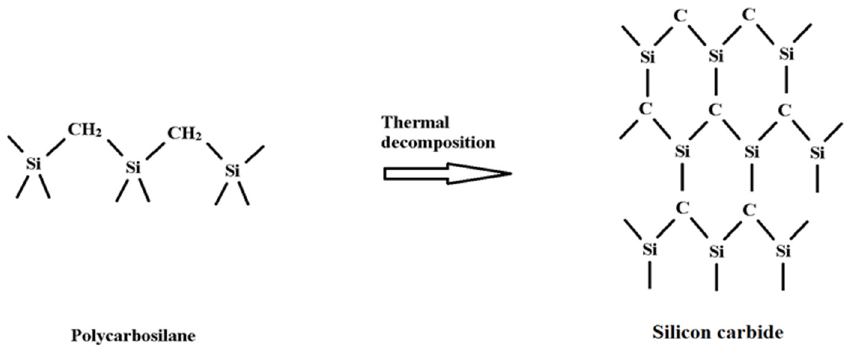
Figure 15. Chemical structure of silicon carbide fiber [132].